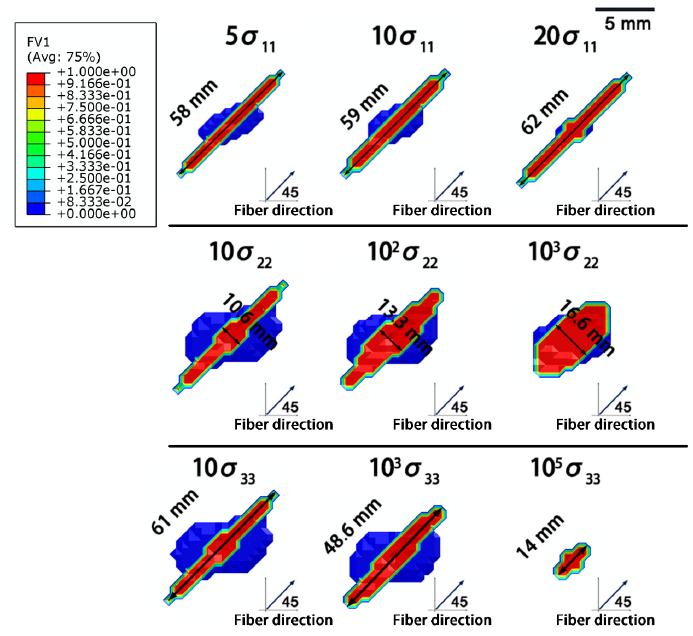
Figure 13. Morphologies of the in-plane damage in composites with different electrical conductivi- ties.